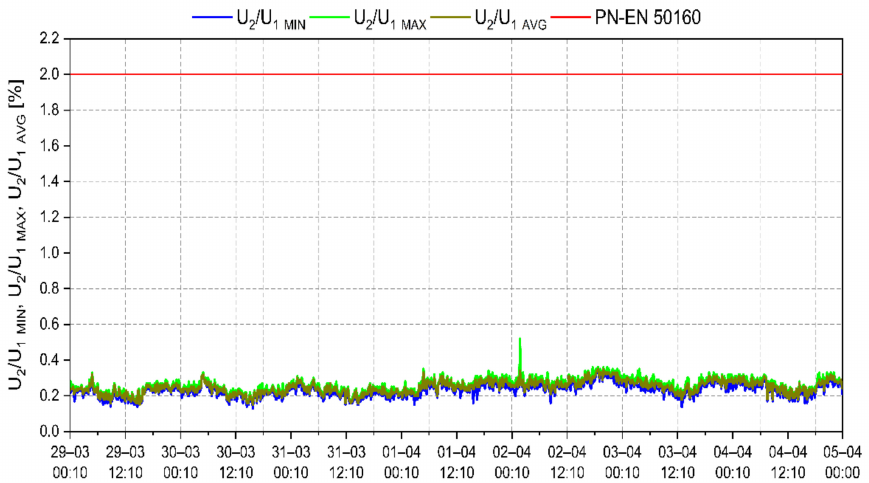
Figure 7. Voltage imbalance factor variation during the measurement week.